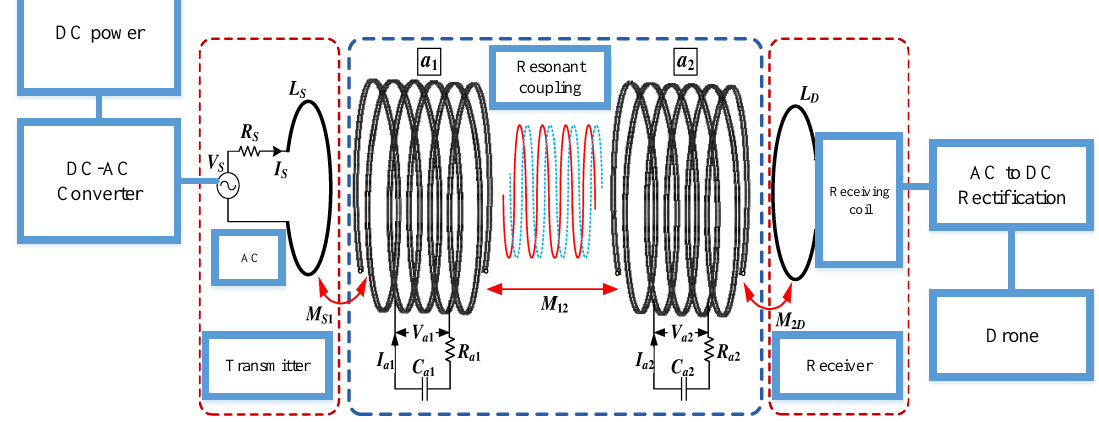
Figure 6. Typical resonant coupling